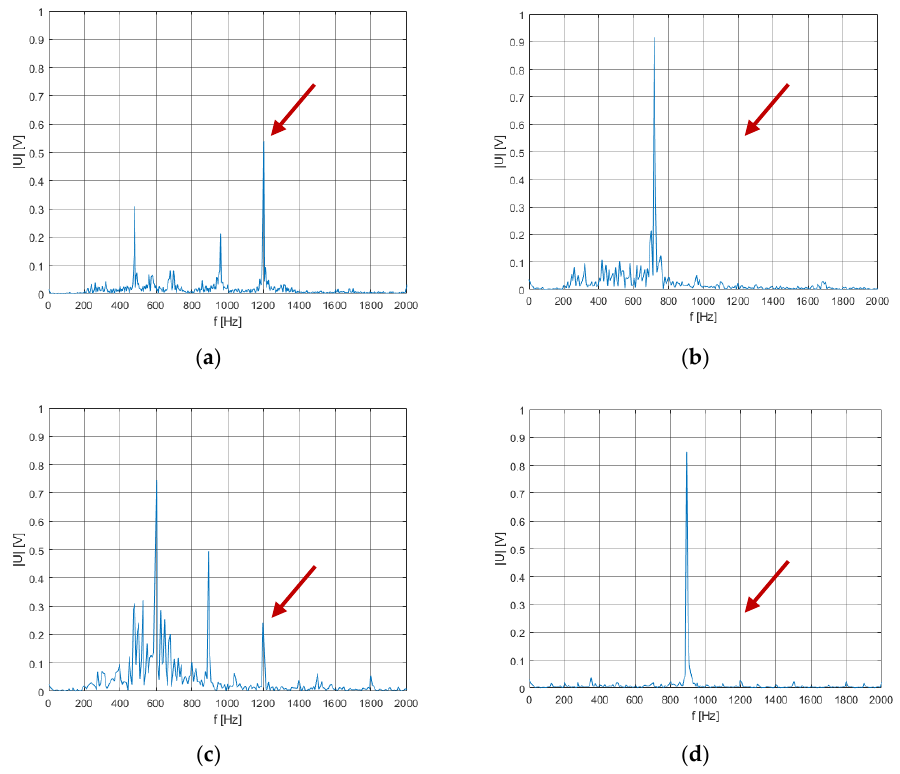
Figure 7. Comparison of vibration spectrum of harmonics for the fundamental frequencies of 40 and 50 Hz: ( a , c ) SCPWM method; ( b , d ) SHE method. 50 Hz: ( a , c ) SCPWM method; ( b , d ) SHE